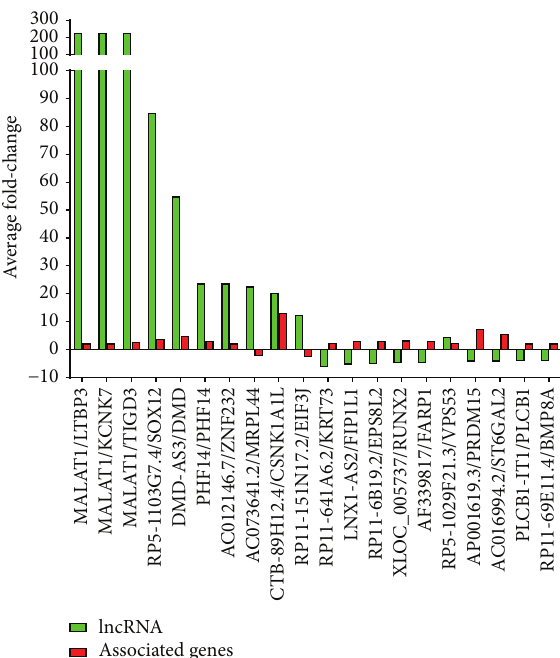
Figure 3: Network coexpression and bioinformatics analyses of samples from HUVECs exposed to TGF 𝛽 1 (10ng/mL) versus control. Representation of differentially expressed lncRNAs and associated genes with respect to fold-change. Eight significantly upregulated and 10 downregulated lncRNAs with known target genes were selected for presentation in the figure.